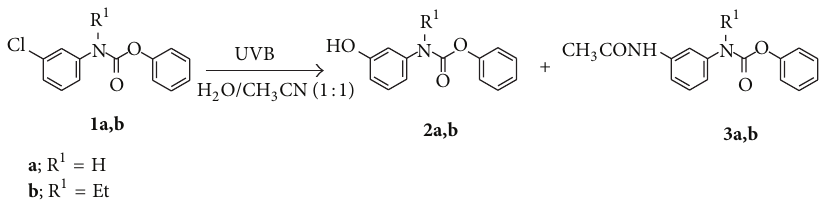
Figure 2: Irradiation of compounds 1a and 1b .